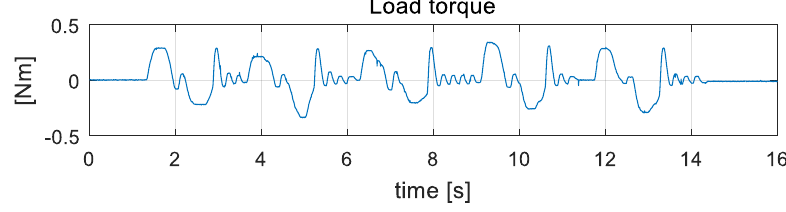
Figure 11. Load torque graph. The maximum torque is 0.33 N.